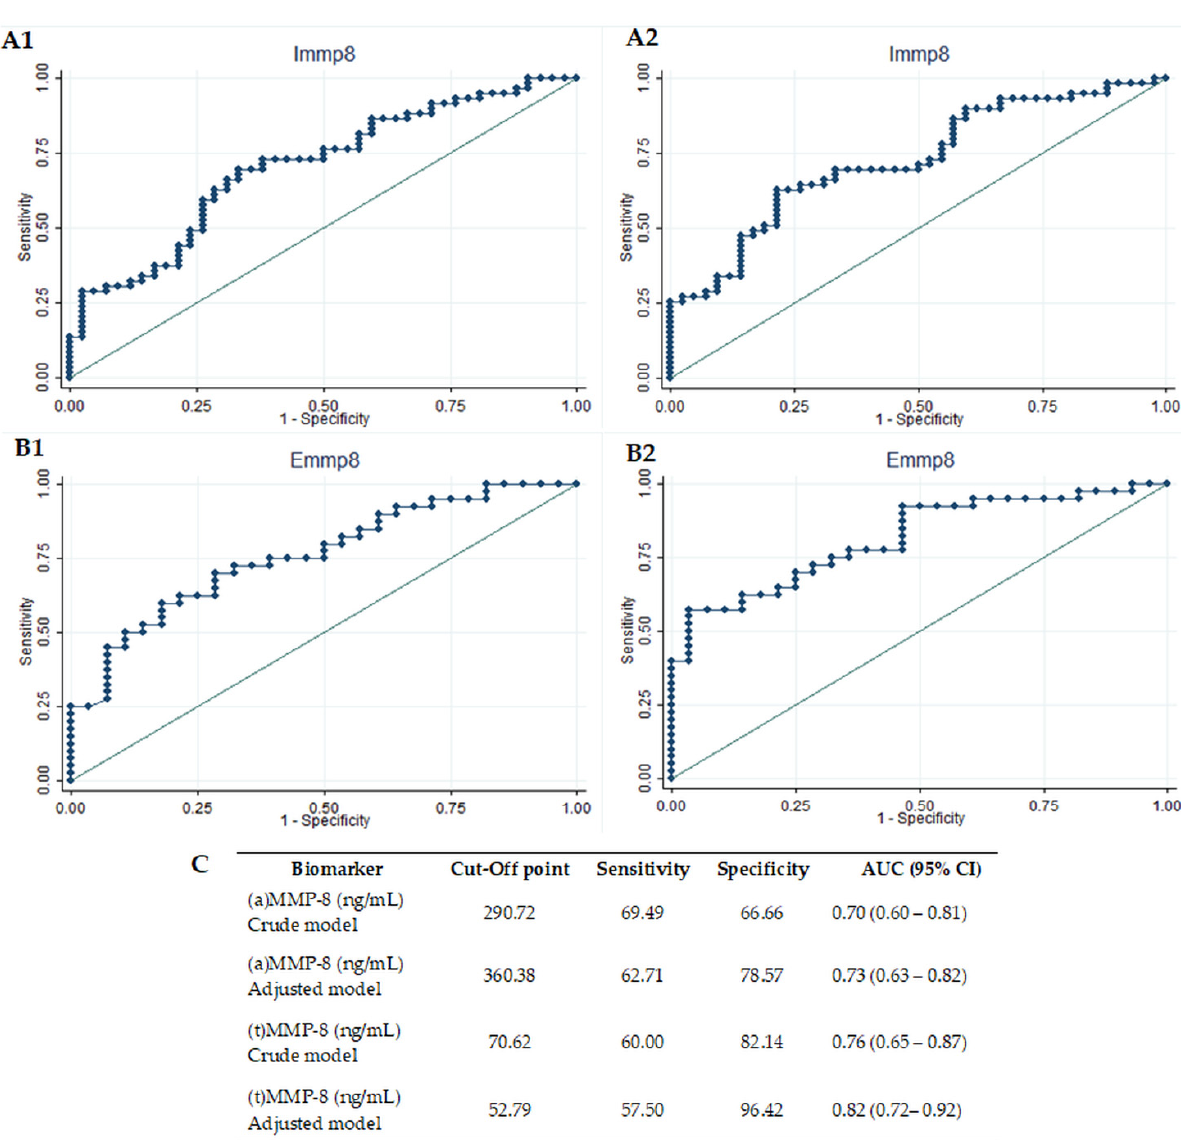
Figure 3. Diagnostic potential of biomarkers to identify severe periodontitis sites. Diagnostic potential of (a) MMP-8 to identify mild from severe periodontitis sites, crude ( A1 ) and adjusted ( A2 ) models; diagnostic potential of (t) MMP-8 to identify mild from severe periodontitis sites, crude ( B1 ) and adjusted ( B2 ) models; ( C ) sensitivity, specificity and cut-off points of (a) MMP-8 and (t) MMP-8. AUC: area under the curve. CI: confidence interval. (a) MMP-8: active matrix metal-